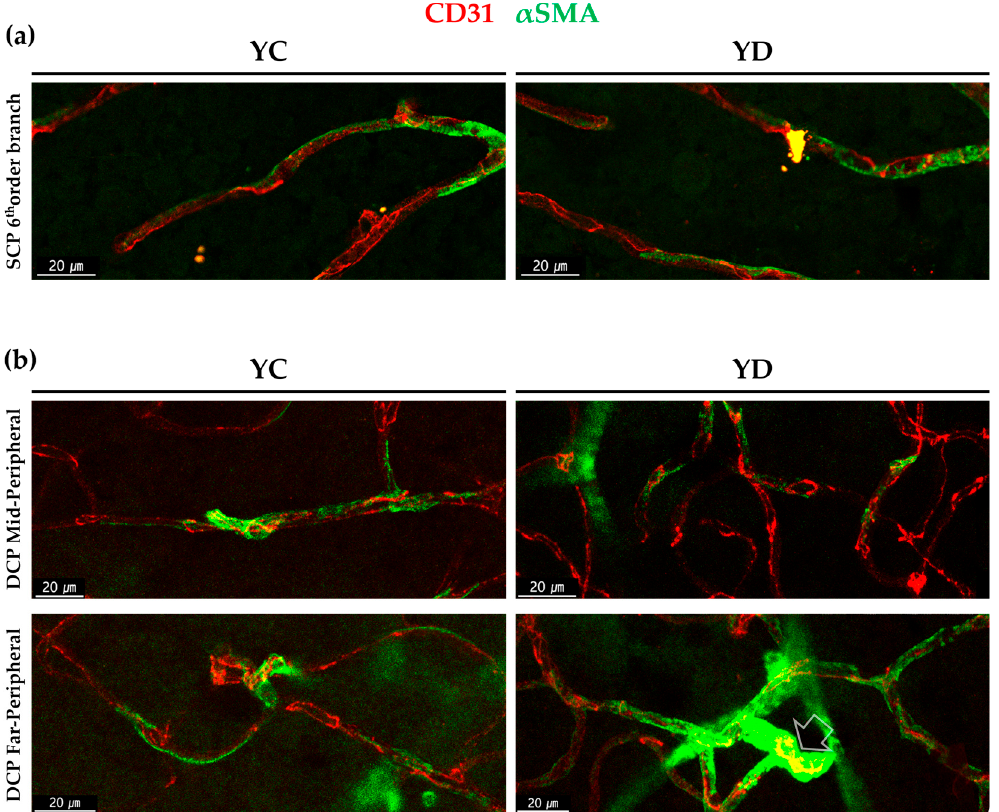
Figure 4. Morphological difference among α SMA positive perivascular mural cells in young diabetic retinal capillaries. ( a ) α SMA positive perivascular mural cells in the 6th order branch in the retinal superficial vessel in YC and YD. ( b ) α SMA positive perivascular mural cells in mid-peripheral and far-peripheral in deep vessels in YC and YD. Note that while YC show overall long, stretching shape, far peripheral YD shows highly dense, fully wrapped around shape at some points (arrow).